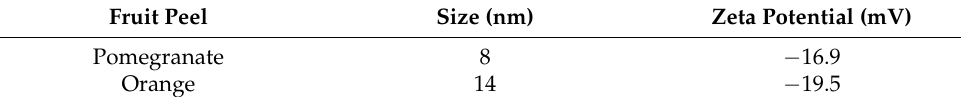
Table 4. Average particle size and zeta potential values measured with a zetasizer nano.